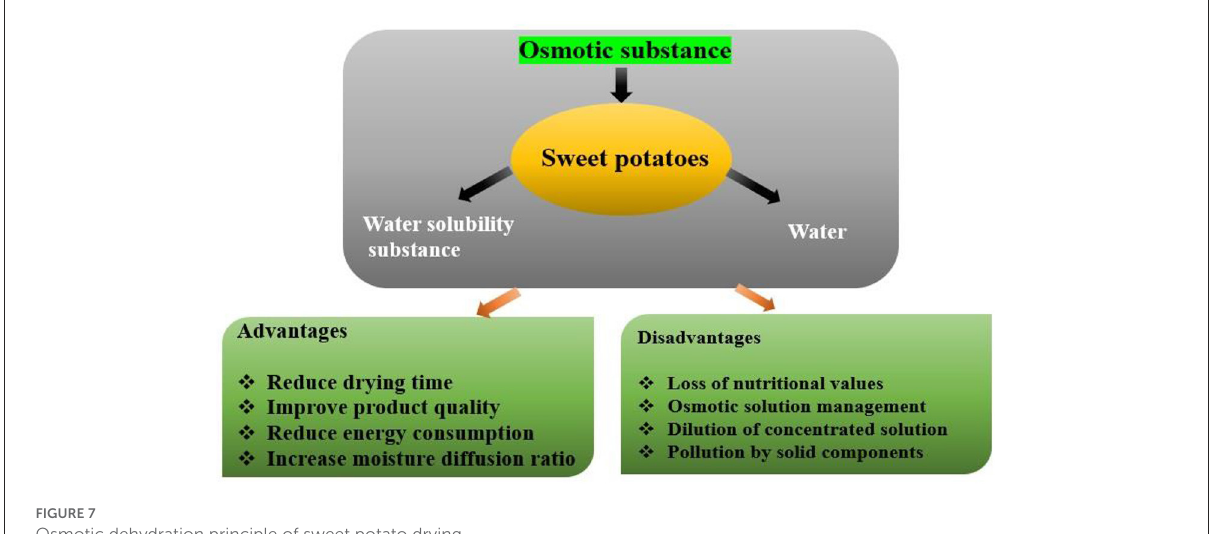
FIGURE7 Osmotic dehydration principle of sweet potato